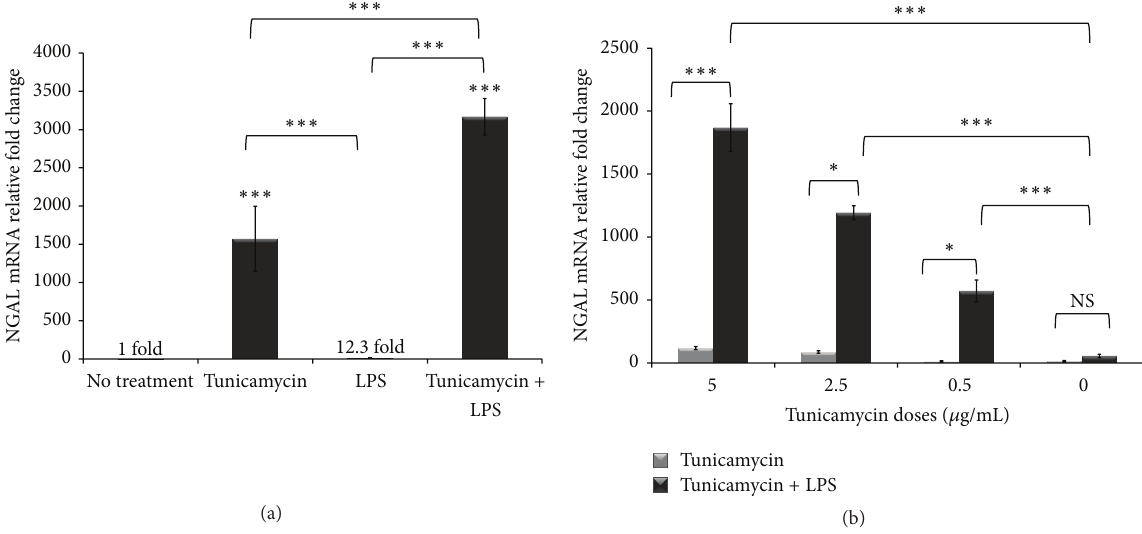
Figure 5: NGAL gene expression is massively upregulated by ER stress. (a) THP-1 cells ( 1 × 10 6 cells/mL) were treated with tunicamycin (10 𝜇 g/mL) or DMSO overnight prior to LPS exposure (40ng/mL) for 6 hr. (b) THP-1 cells ( 1 × 10 6 cells/mL) were treated with tunicamycin doses (5, 2.5, or 0.5 𝜇 g/mL) as in panel (a) or tunicamycin followed by LPS (40 ng/mL). RNA was extracted and NGAL gene expression was assessed by quantitative RT-PCR normalized to 𝛽 -actin. The fold change in NGAL gene expression was calculated in reference to DMSO treatedcontrolTHP-1cellsusingthe ΔΔ CTmethodandpresentedherenormalizedtovehicle(DMSO)treatmentcontrol.Errorbarsrepresent the SD from the mean of three independent experiments. ∗ 𝑃 values were calculated in reference to no treatment (DMSO only) control using one-way ANOVA followed by Bonferroni multiple comparisons post hoc analysis. 𝑃 values annotated ∗∗∗ 𝑃 < 0.0001 ; ∗∗ 𝑃 = 0.001 – 0.01 ; ∗ 𝑃 = 0.01 – 0.05 ; 𝑃 > 0.05 were not significant